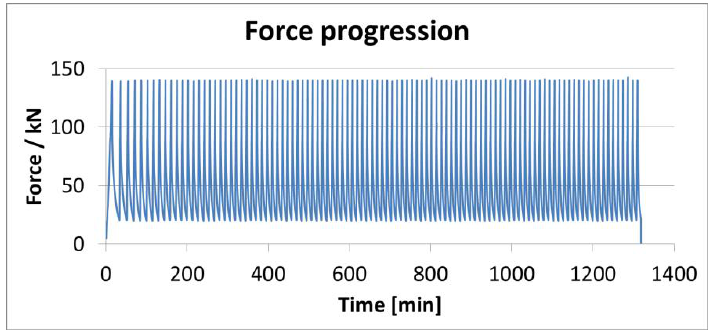
Figure 7. Diagram of UCT’s cyclic load over time for 100 cycles.